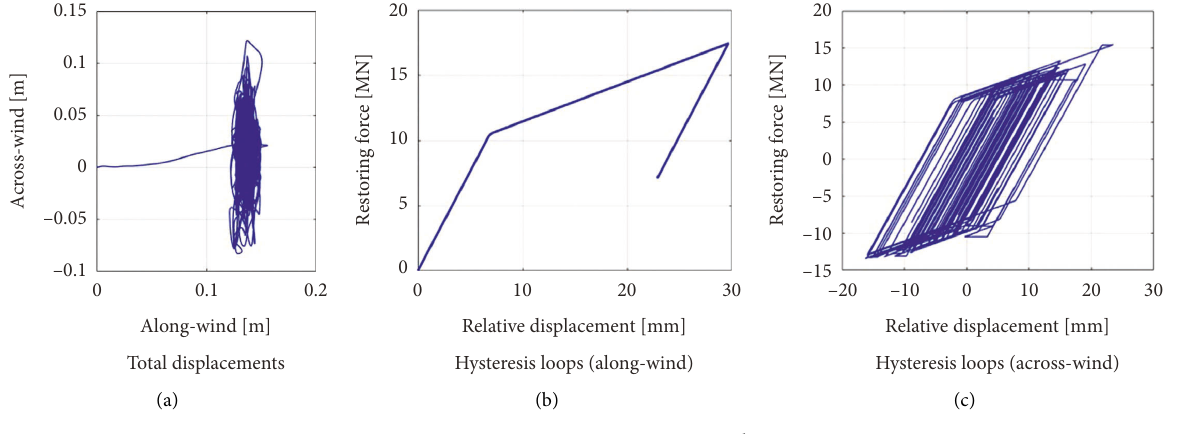
Figure 25: Nonlinear response in time domain of the 5 th floor H/sqrt(BD) �